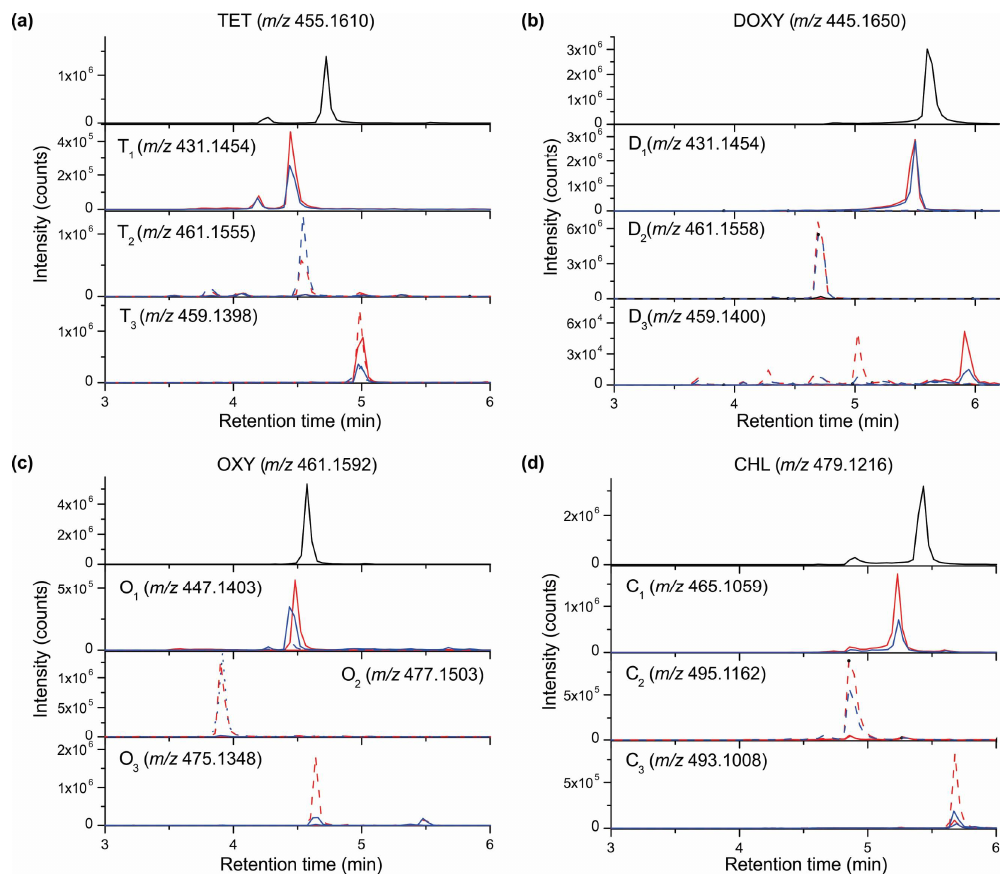
Figure 3. Extracted ion chromatogram of ( a ) TET, ( b ) DOXY, ( c ) OXY, and ( d ) CHL (diluted 1:5) and the oxidation products found after electrolysis in both Britton Robinson buffer pH 9: 0.66 V (red line) and 0.85 V (red dashed line), and pH 4: 0.8 V (blue line) and 1.0 V (blue dashed line) for 60 min.